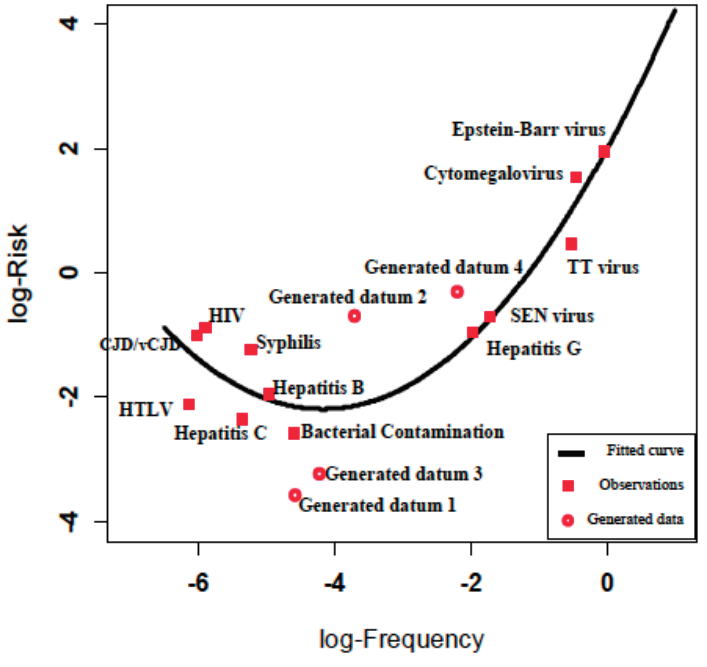
Figure 4. Observed and estimated risk for observations and generated